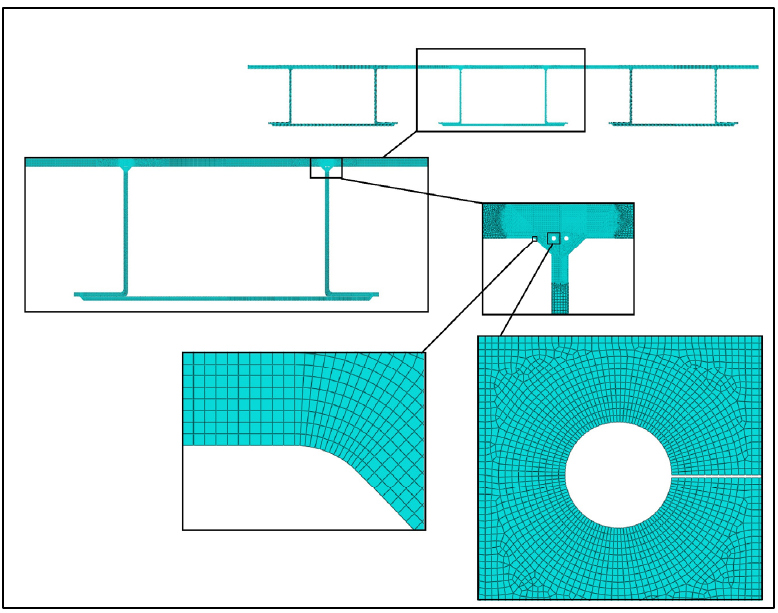
Figure 8. Plane strain assemblies: ( a ) Bulb section; ( b ) Trapezoidal section; ( c ) Built-up section. ABAQUS 4-node CPE4 and 3-node CPE3 plane strain continuum elements were used ABAQUS 4-node CPE4 and 3-node CPE3 plane strain continuum elements were used with various sizes that start at 0.127 mm (0.005 in.) for the region adjacent the joints and increases to 1.27 mm (0.05 in.) in the areas around the connection as seen in Figure 9. The refinement around the joint was made to assure an accurate stress distribution. Weld root and toe details and meshing guidelines as developed by Hobbacher [26] were considered. In particular, a notch radius of 1.016 mm (0.04 in.) was used for the weld toes and the weld roots consisted of 360° keyhole arcs. Further mesh refinement at the weld arcs were con- sidered to satisfy the minimum recommended number of elements (i.e., 5 at toe’s arc and and 40 at the root’s arc). 40 at the root’s arc).